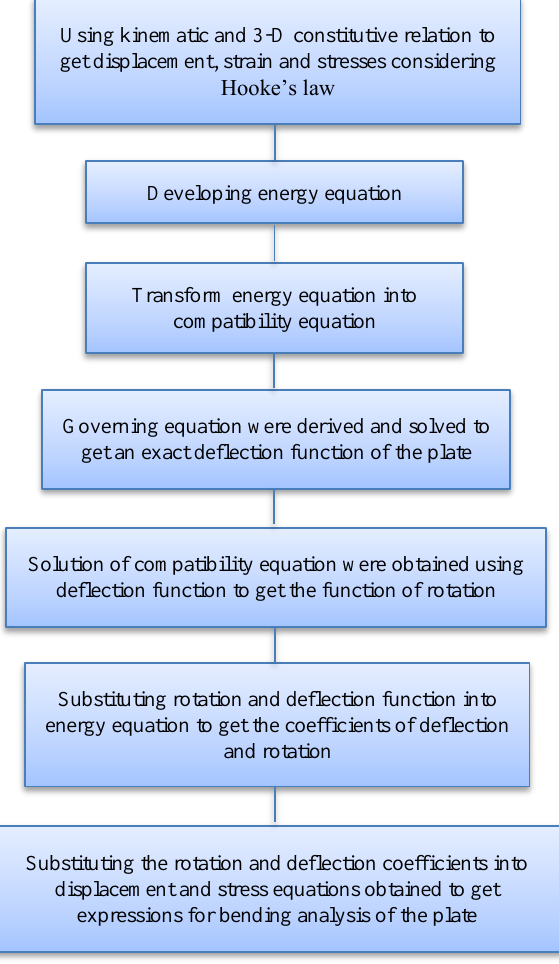
Figure 1. Flowchart to the article analysis procedure as presented in the research